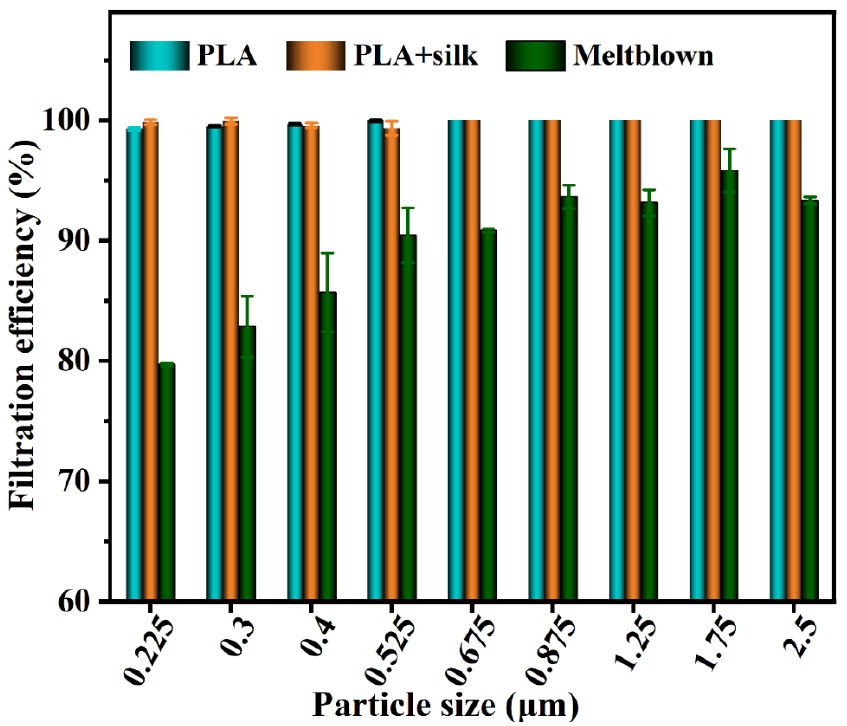
Figure 8. The filter efficiency of PLA spun for 40 min, PLA+silk, and melt-blown samples.